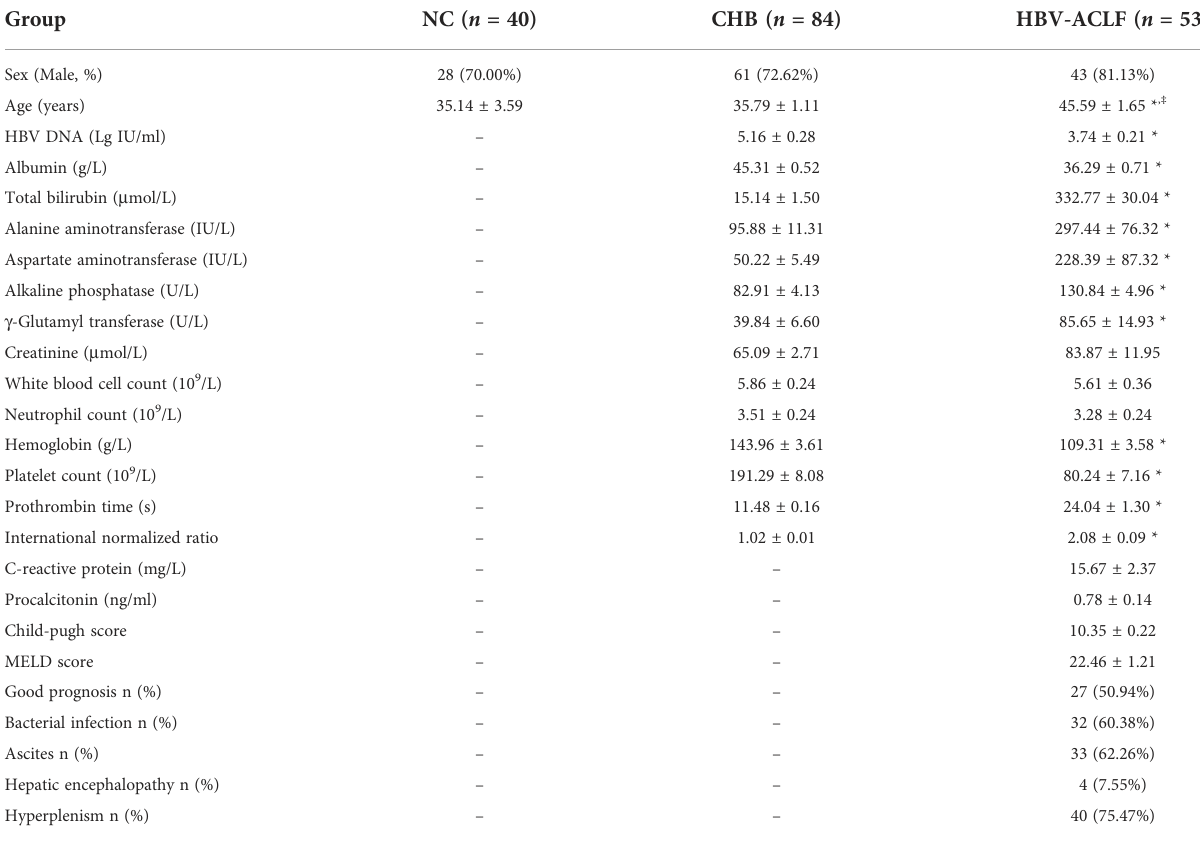
TABLE 1 Demographic and clinical characteristics of